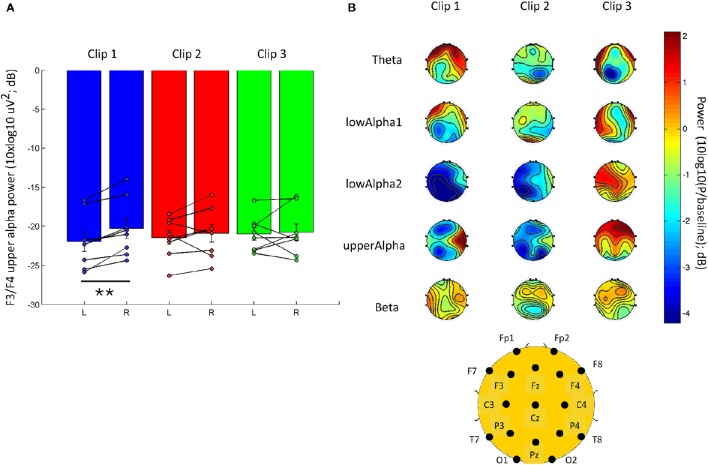
EEG responses to each clip presentation. (A) F3 and F4 frontal upper Alpha power (10log10 uV2) for the first 10 s of clip presentation for clip 1 (happy), clip 2 (relaxed), and clip 3 (vigorous). (B) The overall topographic EEG changes from the baseline for the early presentation of each clip (first 10 s). The power is normalized to the baseline (division) and log transformed (10*log10) to provide the baseline change in dB. See Figure S6 the full temporal dynamics of the EEG response to each clip. Data are presented on a scatter plot and mean ± s.e.m; ** indicates a p ≤ 0.001.